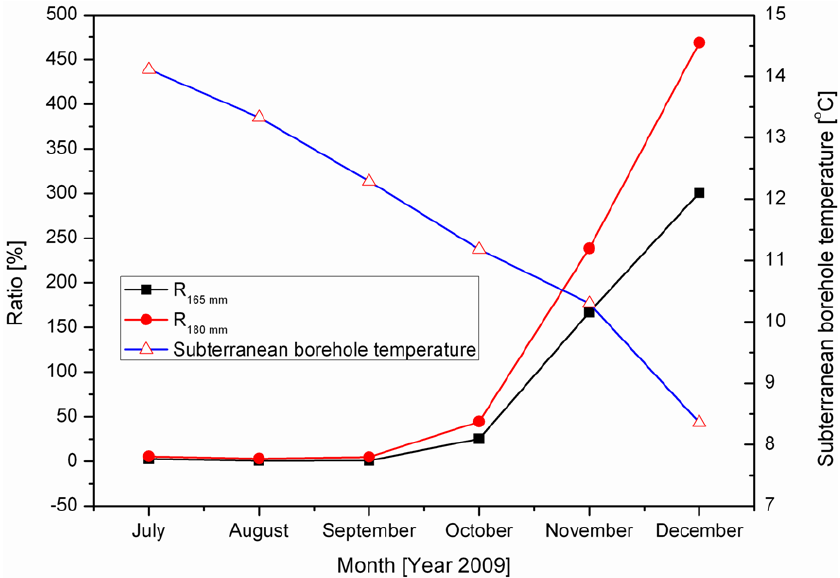
Figure 13. Thermal efficiency comparison of the BHE under different subterranean borehole